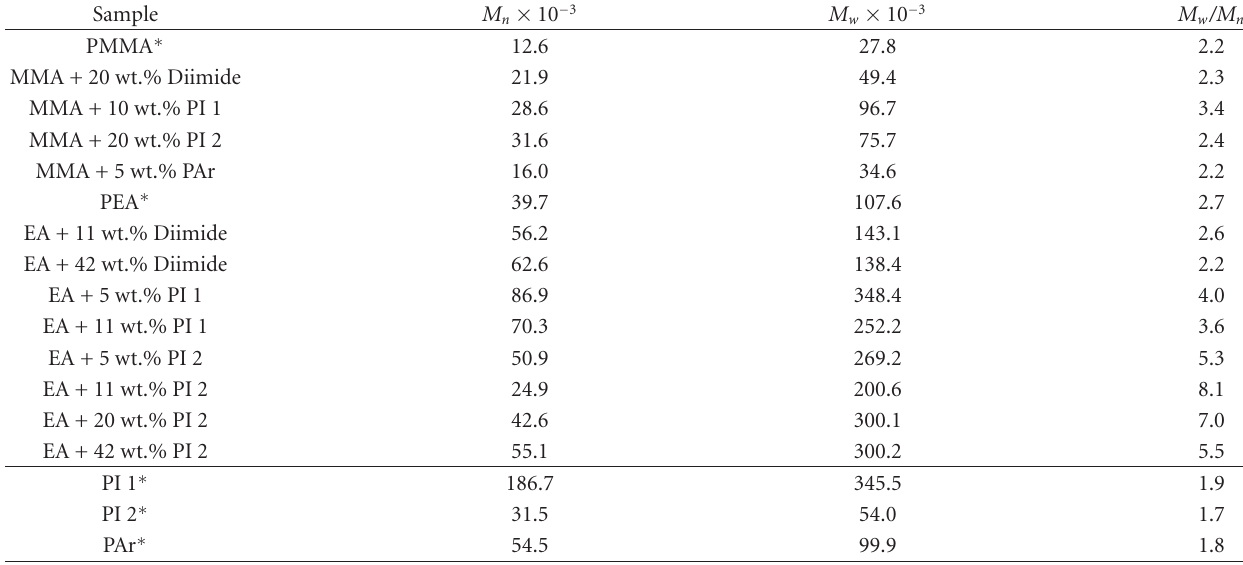
Table 5: SEC results of polymers based on MMA and EA.